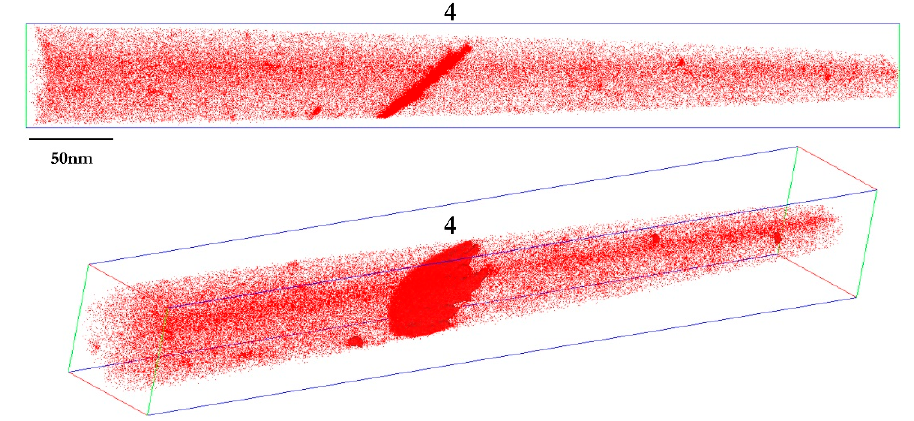
Figure 16. Carbon distribution map in martensite with one carbide (QT200 / 200 s). The total volume analyzed was 60 nm × 60 nm × 500 nm containing 37 × 10 6 ions. A 5 at % C isosurface is also represented in red to highlight the carbide.